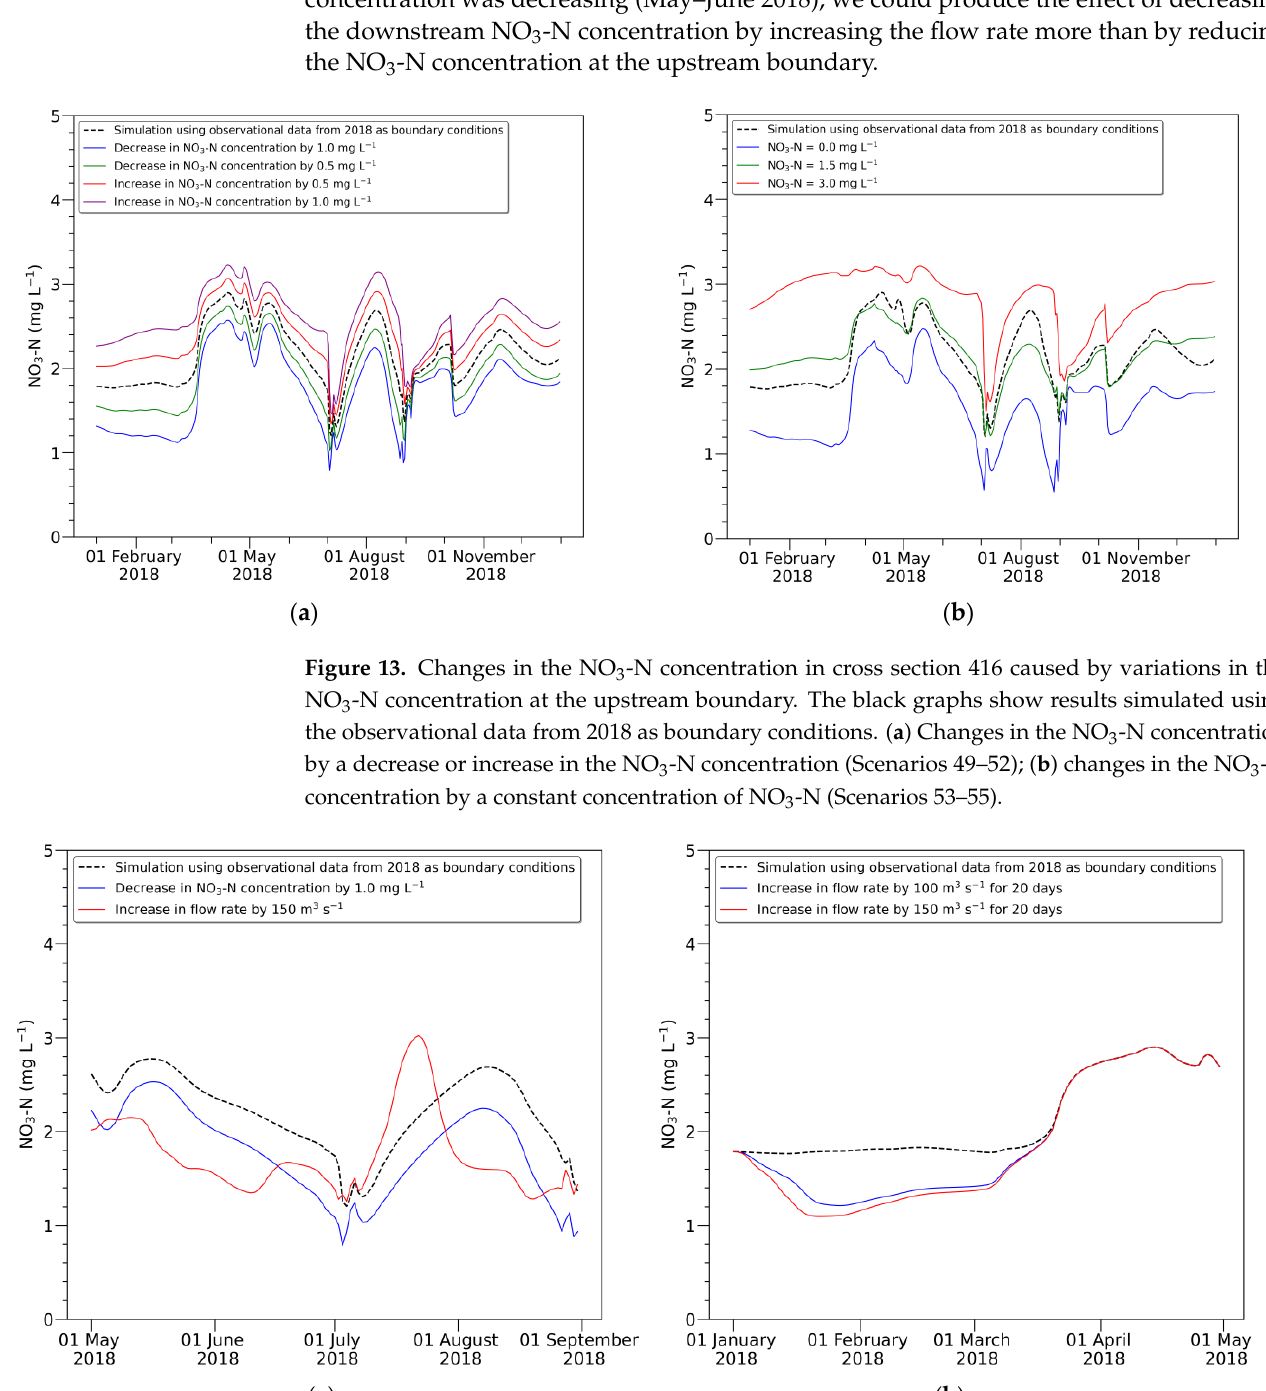
Figure 13. Changes in the NO 3 -N concentration in cross section 416 caused by variations in the NO 3 - N concentration at the upstream boundary. The black graphs show results simulated using the ob- servational data from 2018 as boundary conditions. ( a ) Changes in the NO 3 -N concentration by a decrease or increase in the NO 3 -N concentration (Scenarios 49 – 52); ( b ) changes in the NO 3 -N con- centration by a constant concentration of NO 3 -N (Scenarios 53 – 55). peak concentration in the blue graph was lower than the peak in the red graph when the